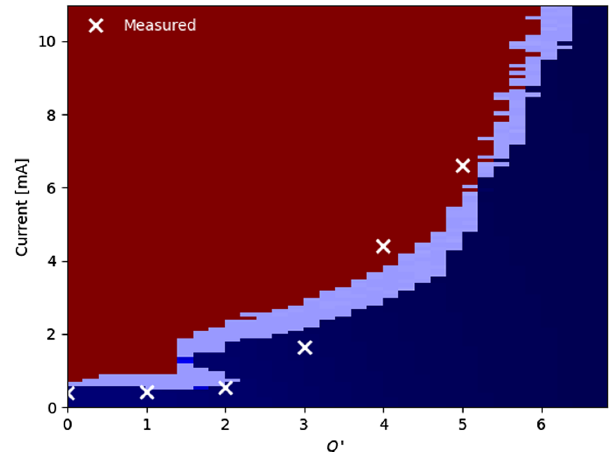
FIG. 13. Vertical instability threshold as a function of chro- maticity. The white crosses are measurements and the shaded regions show the simulated area of stability (dark blue) or instability (red, light blue).